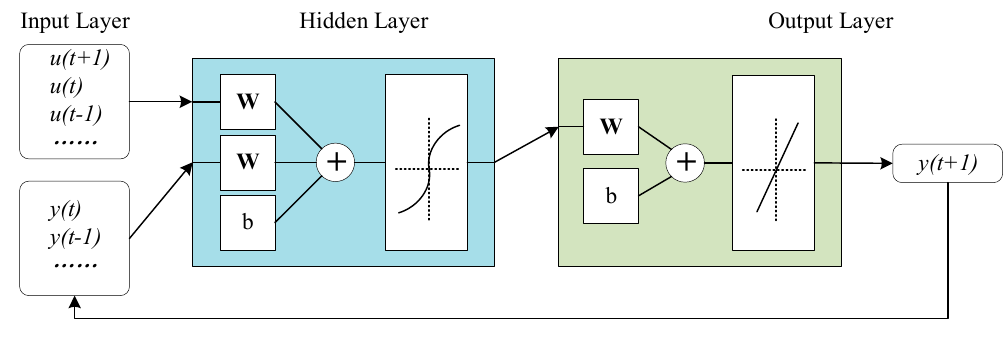
Figure 2. Structure of NARX.